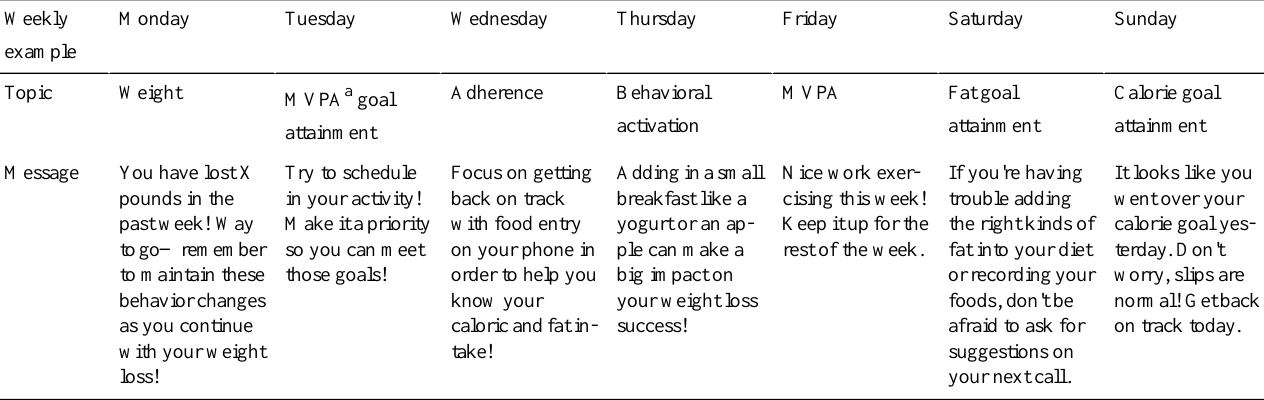
Table 2. Sample weekly text schedule with example content. SundaySaturdayFridayThursdayWednesdayTuesdayMondayWeekly example